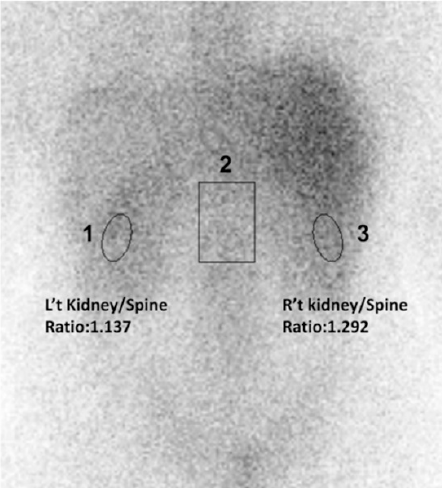
Figure 1. Semiquantitative measurement calculated by kidney/spine ratio from 67Ga renal image (posterior view) in a patient with lupus nephritis. ROIs on scintigraphy image: ROI 1: left kidney; ROI 2: spine; ROI 3: Right kidney. ROI: region of interest.